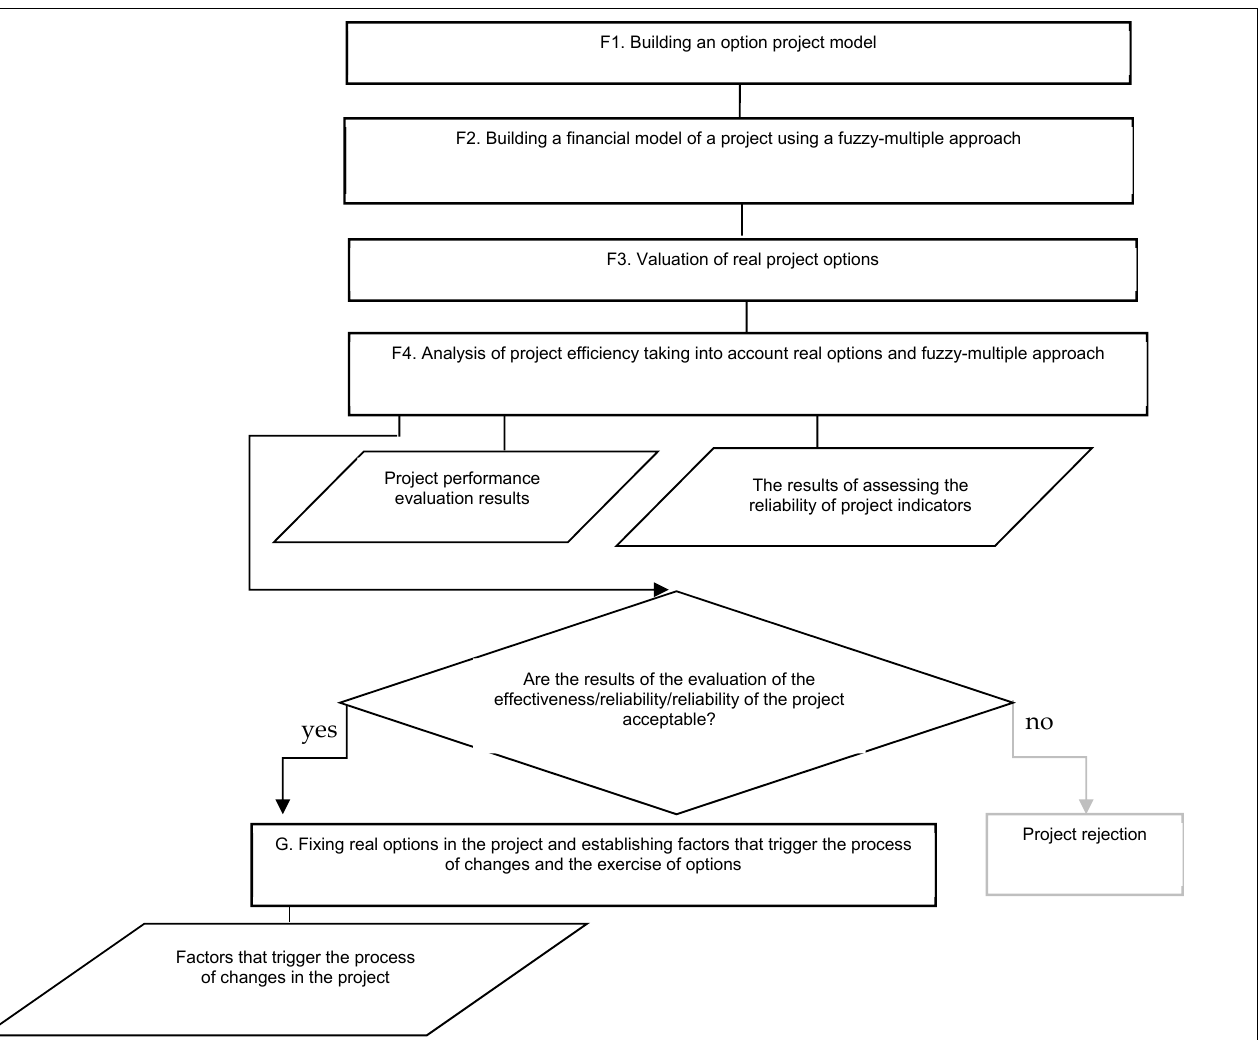
Figure 1. An enlarged algorithm for analyzing and evaluating the effectiveness of innovative projects based on the concept of real options and a fuzzy-multiple approach.